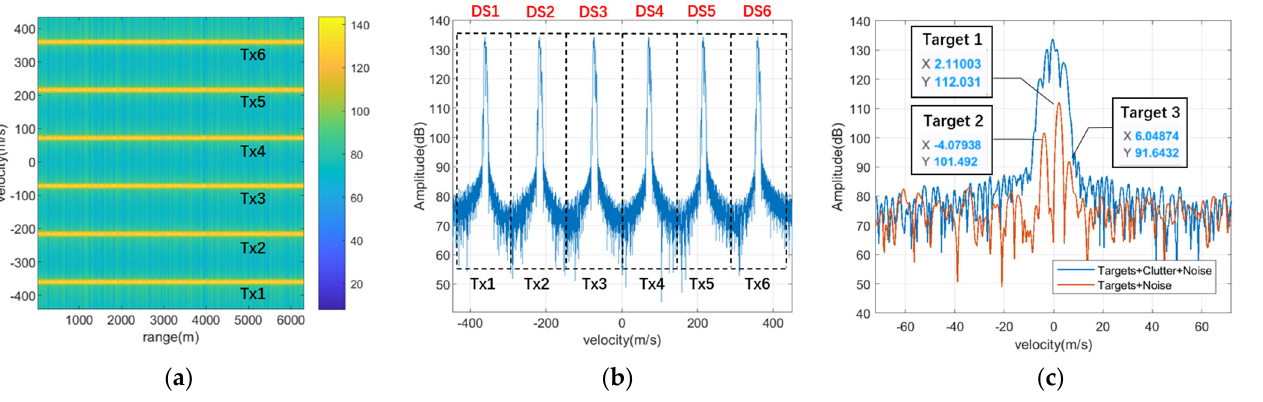
Figure 5. Results of signal modeling: ( a ) Range–velocity map of the received signal in antenna 1 after PD processing, where waveform diversity was formed via st-MIMO; ( b ) velocity spectrum at targets’ range bin in antenna 1, where six Doppler sub-bands (DS1-DS6) were established and echoes from the six transmitting antenna (Tx1–Tx6) can be seen; ( c ) velocity spectrum of Channel 1 after MIMO demodulation, where three targets can be seen in the red line of targets plus noise.